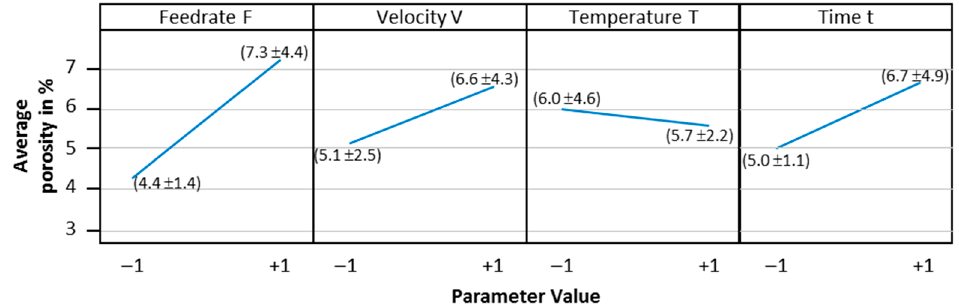
Figure 10. Main effects of the parameters F, V, T and t on the average porosity.